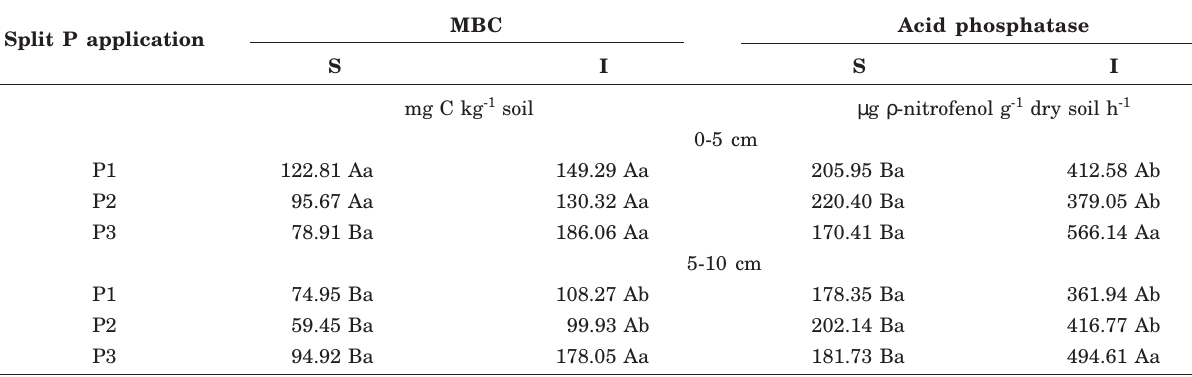
Table 2. Microbial carbon (MBC) and acid phosphatase of a dystrophic Red Latossol, under split P applications and irrigation regimes, in two